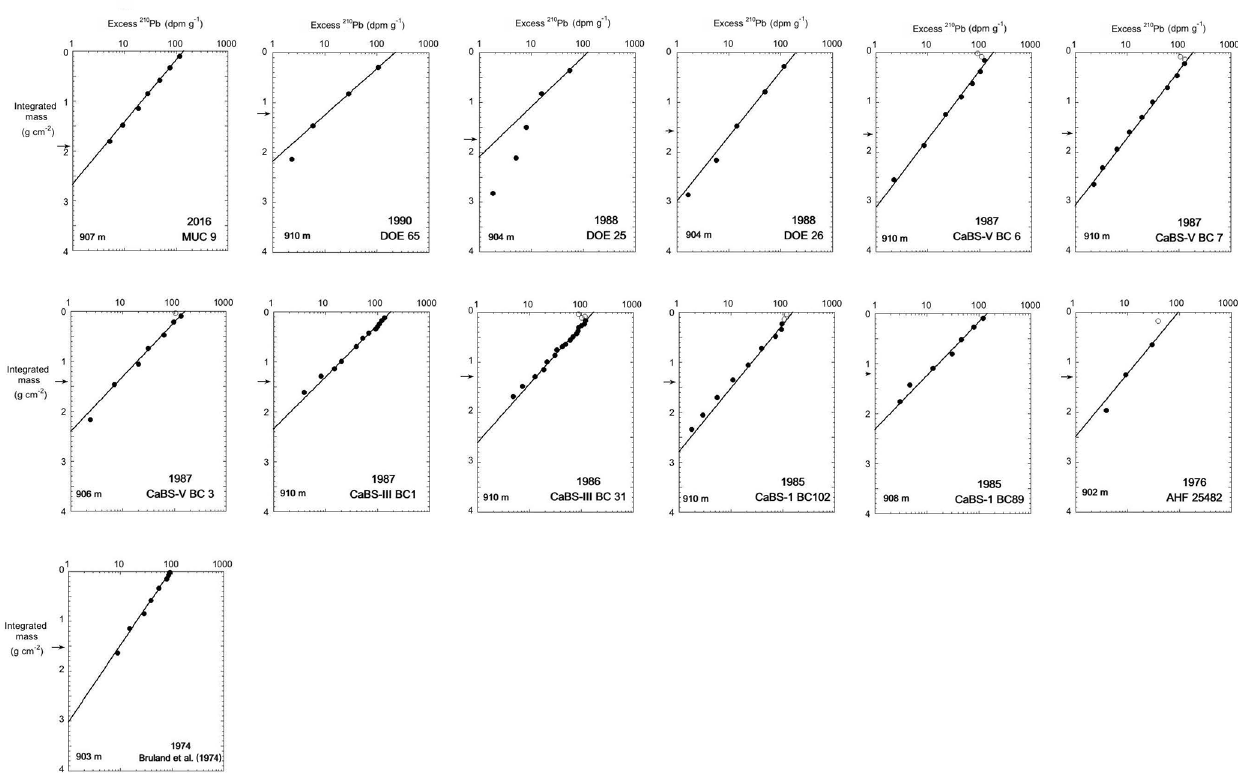
Figure 11. Semi-log plot of excess 210 Pb activity vs. integrated mass for 13 cores sampled in the Santa Monica Basin in the years 1974–2016. The linear fit to these plots yield slopes that define the mass accumulation rate (see Table 2). Arrows on the y axis indicate the integrated mass equivalence to